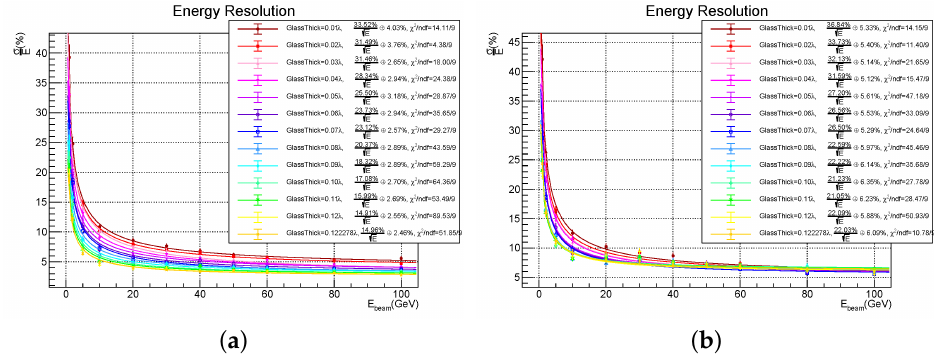
Figure 4. Energy resolutions of the HCAL with different thicknesses of scintillating glass for K 0 with the kinetic energy ranging from 1 GeV to 100 GeV. The glass thickness varies from 0.01 λ I to 0.12 λ I and corresponds to solid points in different colors (dark red and orange for the minimum and maximum sampling fraction, respectively) with different energy thresholds per channel of 0–0.3 MIP. The sampling fraction uses the energy deposition obtained directly from Geant4, without considering the readout implementation or corrections. ( a ) Threshold = 0 MIP per channel; ( b ) threshold = 0.3 MIP per